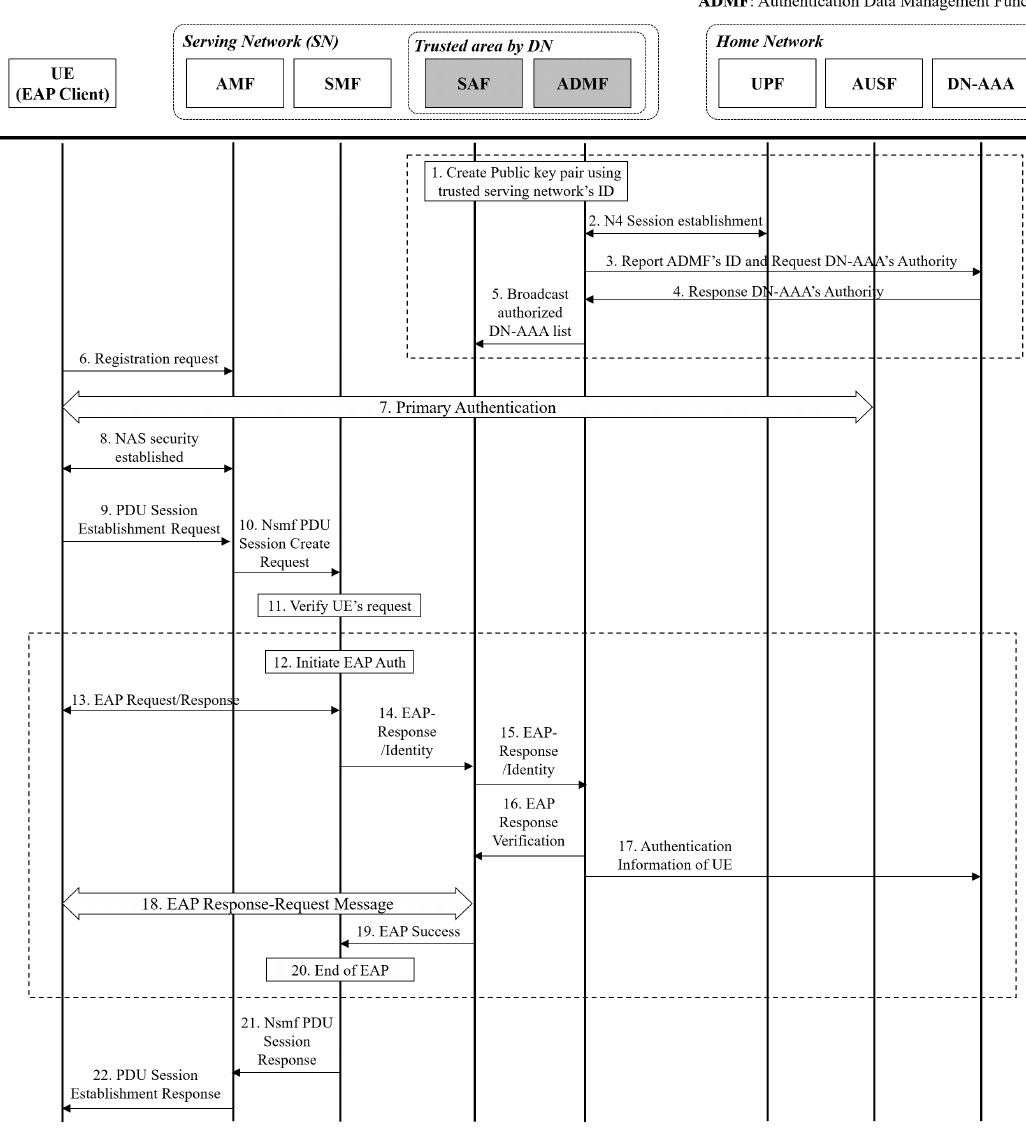
Figure 2. The initial secondary authentication with Secondary Authentication Function (SAF) and Authentication Data Management Function